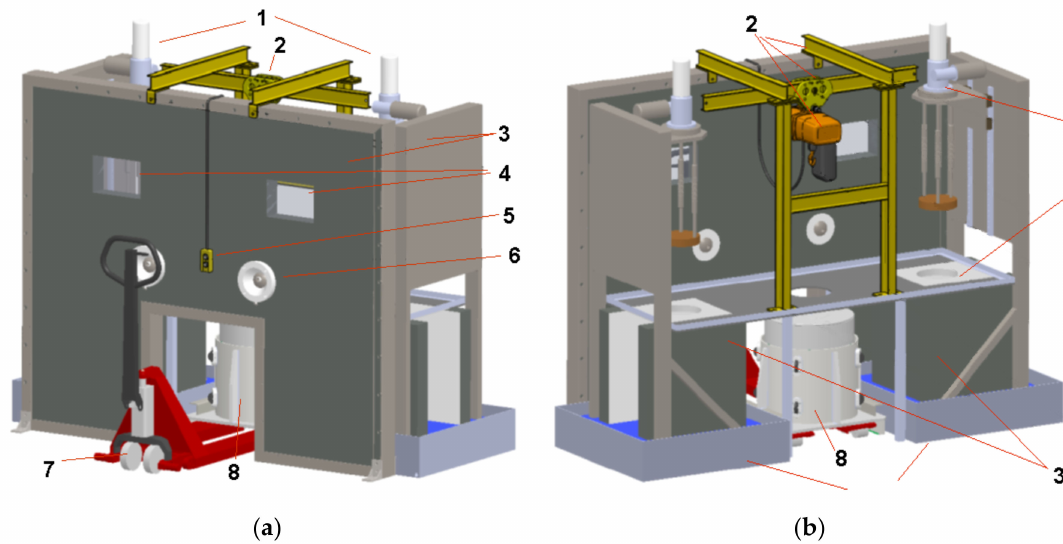
Figure 12. ( a ) Front and ( b ) back views of the autoclaves with local shielding and associated equipment: (1) autoclaves with stepper motor controlled loading, (2) hoist with supporting structure, (3) lead shielding, (4) leaded windows, (5) hoist hand controller, (6) remote handling tong support (tongs not present), (7) hand pallet truck, (8) transport